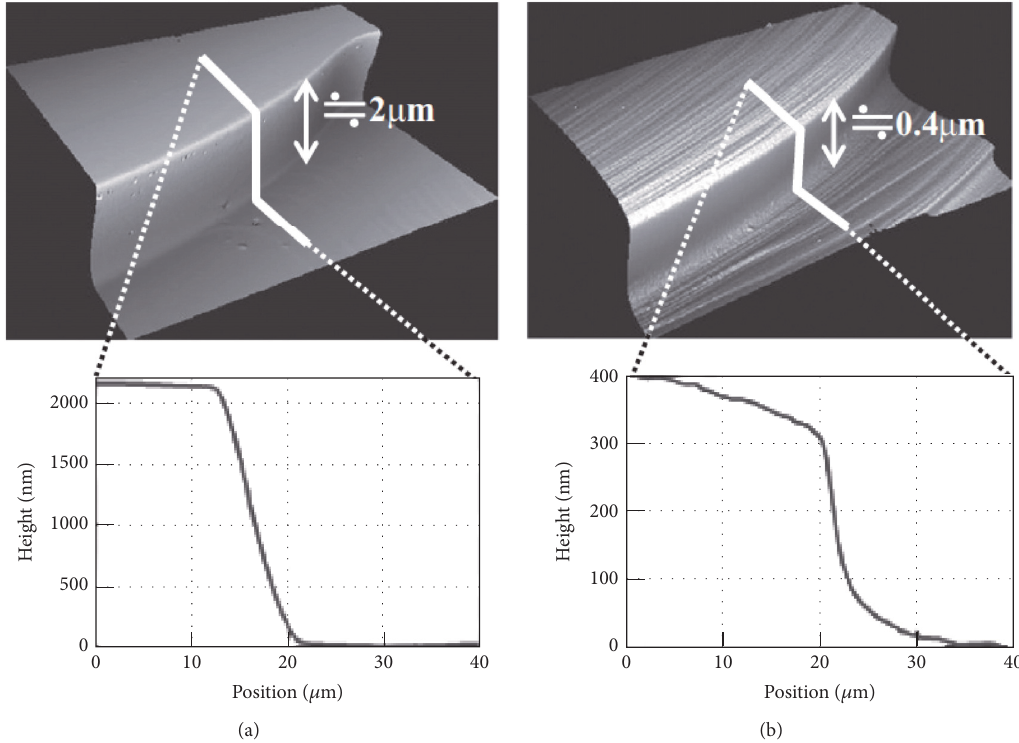
Figure 1: Three-dimensional profiles of macrostep growth of 4H-SiC with (a) Si 0.5 Cr 0.5 and (b) Si 0.46 Cr 0.5 Al 0.04 solvents. The lower graphs show the 2D height profiles of the macrosteps indicated by the white lines in the upper figures. Reprinted from [1], Copyright (2015), with permission from Elsevier.